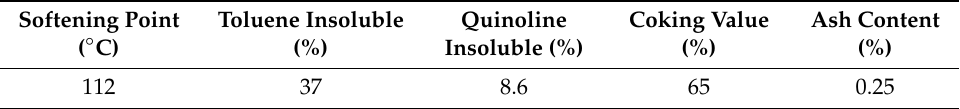
Table 1. The properties of binder